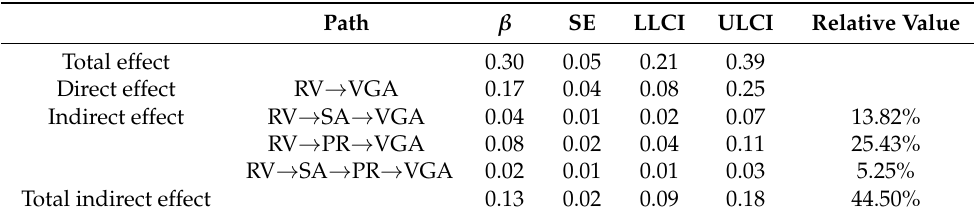
Table 3. Total, direct, and indirect effects of relational victimization on video game addiction through social anxiety and parasocial